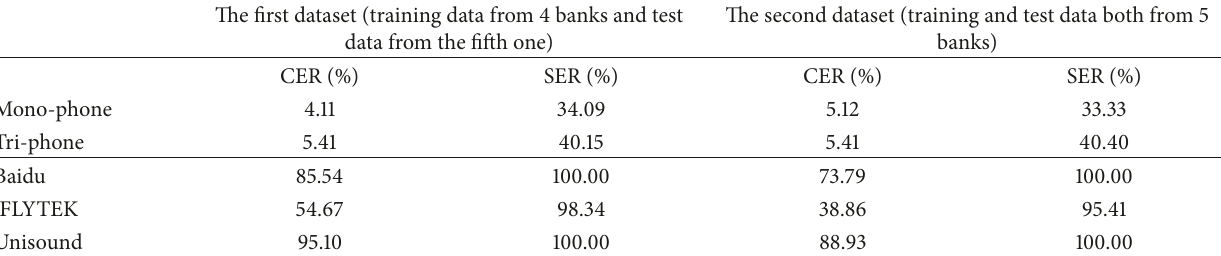
Table 3: Results of audio announcement